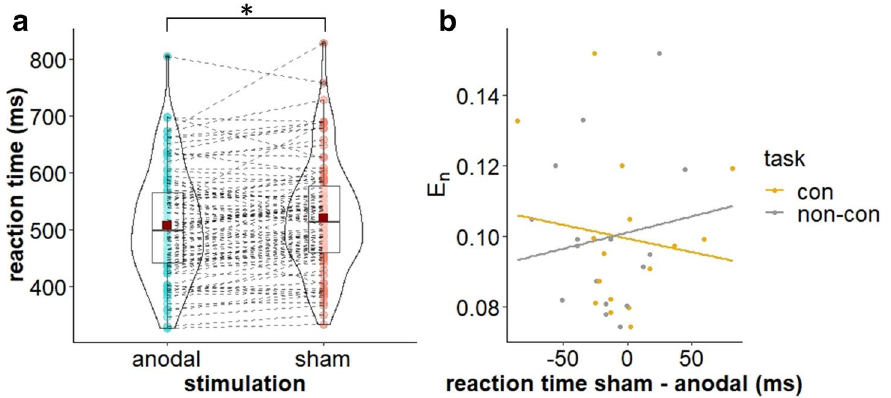
Figure 5. Stimulation effects on Flanker performance. (a) Violin plot for mean (± SD) and individual Flanker RT for sham and multichannel stimulation, averaged over concurrent and non-concurrent task condition. Red squares indicate mean RT, coloured dots indicate individual RT (* p < 0.05). (b) Scatter plots with regression lines of stimulation effect (sham-anodal) on Flanker RT and individual normal E-field component (E n ) for concurrent (con) and non-concurrent (non-con) task